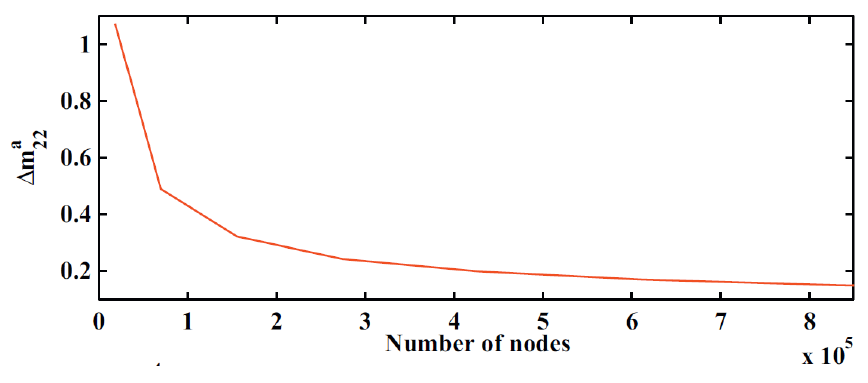
Figure 5. Mesh sensitivity